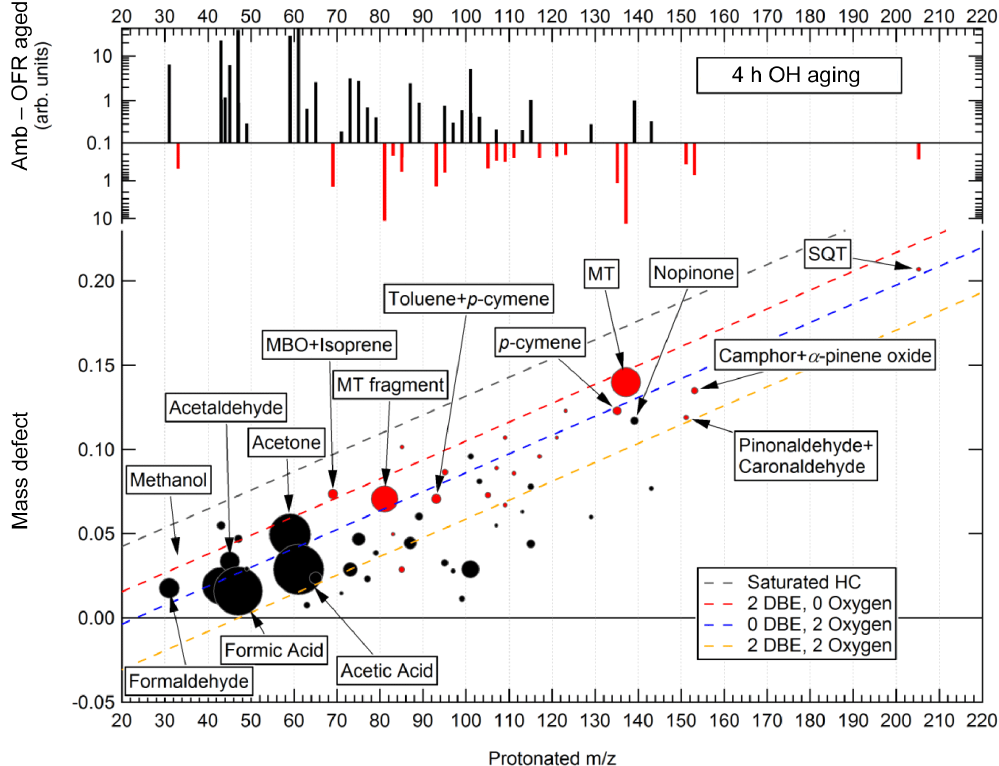
Figure 3. The absolute changes (signal after OH oxidation in the reactor minus ambient signal) of molecules measured by the PTR-TOF-MS after 4h of eq. aging using the OFR185 method, shown as a difference mass spectrum and in a mass defect diagram. The mass spectra are 10min averages (5min from each of the two sample cycles used). The background-subtracted signals are shown in arbitrary units, not corrected for differences in sensitivity of each compound due to the large number of compounds and the inability to positively identify all of them. Prominent molecules are labeled by name or elemental formula assignments. Dashed lines representing molecules with varying double bond equivalents (DBEs) or number of oxygen atoms are shown for reference. A red marker signifies that the signal decreased due to oxidation, while a black marker indicates where signal was greater after oxidation. The markers are sized by the square root of the absolute change in signal at each peak after oxidation (i.e., marker area is proportional to signal). Minor signals with absolute change of <0.2 arbitrary units or change of <20% of total ambient signal were